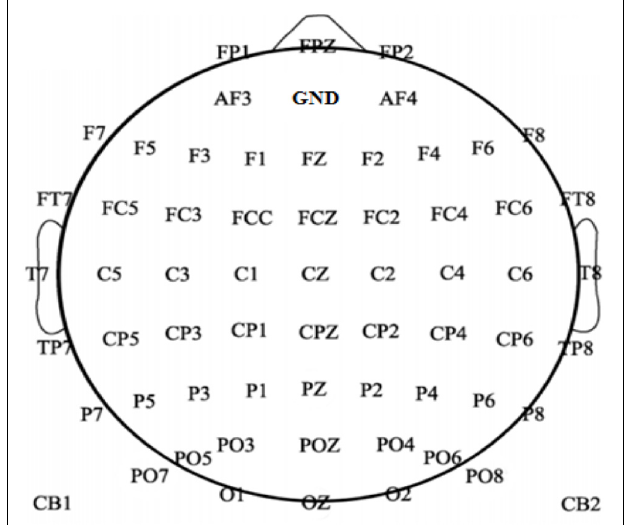
FIGURE 1 | Electrode positions; 64 channels (FPZ, FP1,2, AF3,4, FZ, F1-8, FCZ, FC1-6, FT7,8, CZ, C1-6, T7,8, CPZ, CP1-6, TP7,8, PZ, P1-8, POZ, PO1-8, OZ, O1,2, CB1,2) were collected during the experiment. All the electrodes were referenced to the right mastoid using a forehead